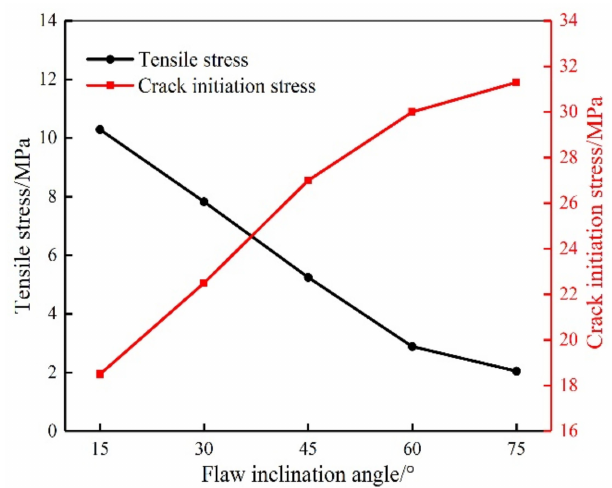
Figure 13. Variation of the maximum tensile stress around the flaw and the crack initiation stress with the flaw inclination